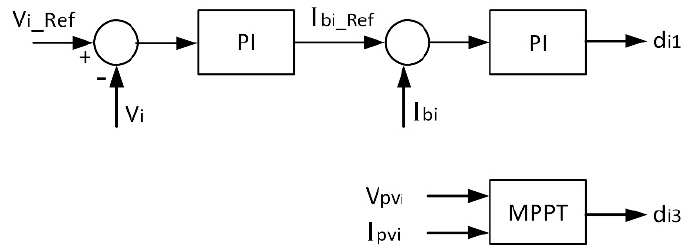
Figure 9. Block diagram of MMPC local control loop.